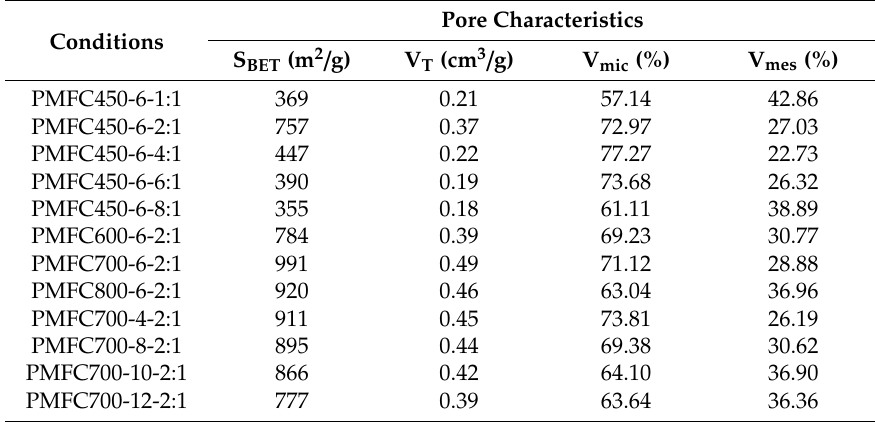
Table2. Texturalporecharacteristicsofas-preparedPMFsnanoporouscarbons.